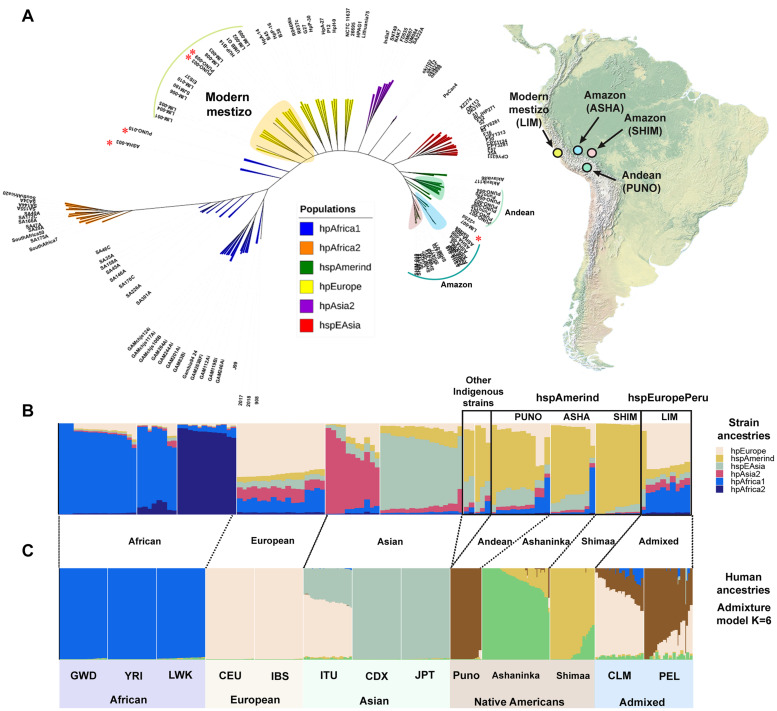
Phylogenomic relationships and population structures of H. pylori and human populations. (A) Global phylogenomic tree for 127 H. pylori strains. The tree was constructed from a total of 930,403 SNPs with a K value of 29 using KSNPV3.0. The shading blue (ASHA) and red (SHIM) are the strains obtained from the Amazon, the light green (PUNO) are the strains isolated from Puno in the Andes, and the light yellow (LIM) represent the strains isolated from Lima. The Peruvian map shows the regions where the samples were collected. The asterisks represent the heavily admixed strains (ASHA-003, PUNO-003, PUNO-009, PUNO-010, and LIM-007). (B) Ancestry profiles inferred using Chromopainter v2/fineSTRUCTURE for 127 H. pylori strains (32 study and 95 references; Supplementary Table S4). (C) ADMIXTURE results for 10 human populations from 1000 Genomes (n = 250) and Borda et al. (2020) (n = 74; Supplementary Table S1). We plot admixture results for the K value with the lowest cross validation error (K = 6; Supplementary Figure S2).